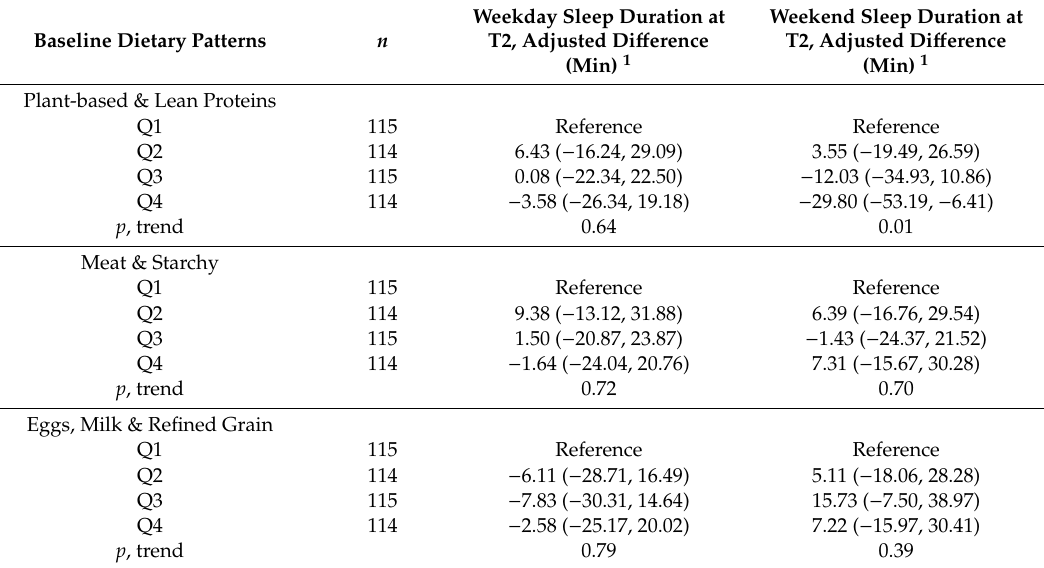
Table 3. Multivariable associations between baseline dietary patterns and prospective sleep duration.